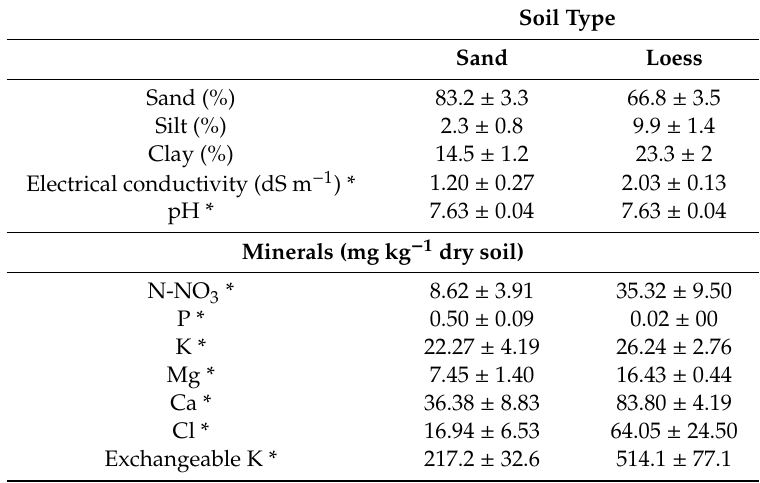
Table 1. Soil composition and minerals before the growing season. Data are average of three replicates with